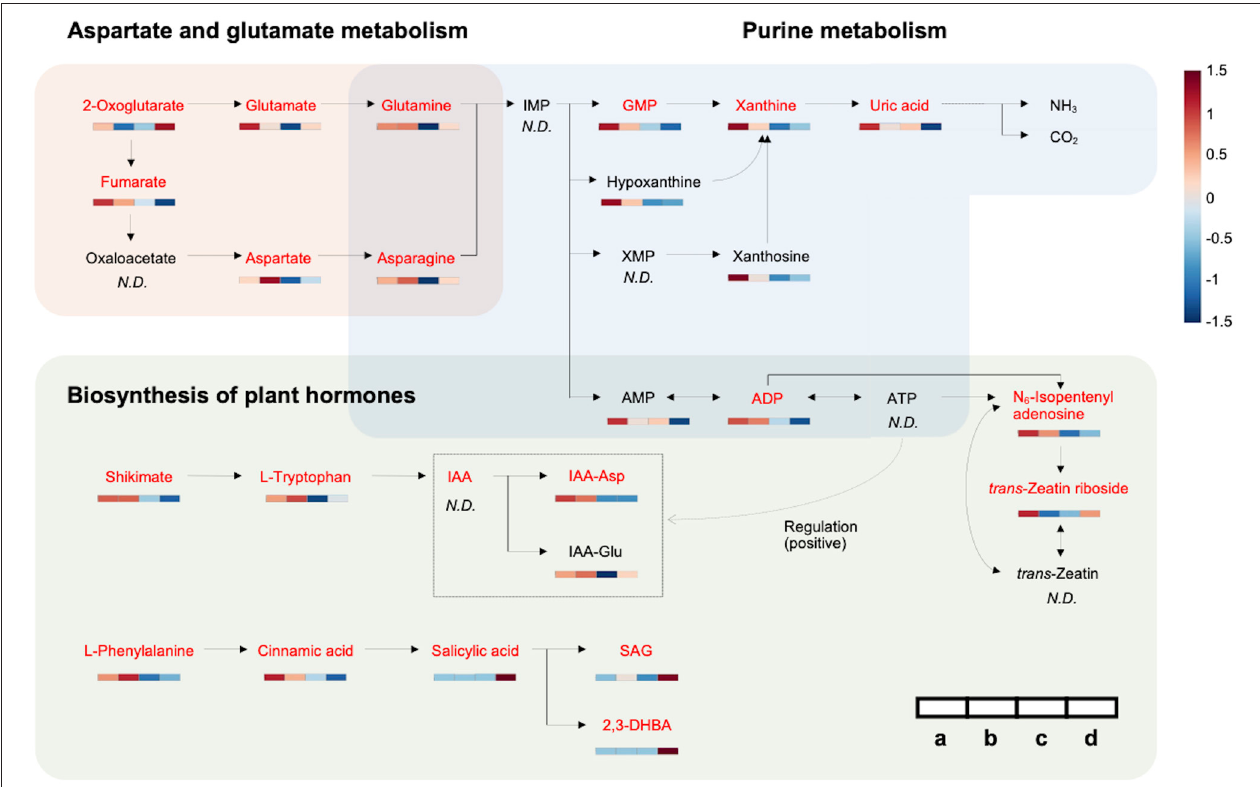
FIGURE 3 | Metabolic network associated with HLB tolerance based on an integrated pathway. Heat maps show metabolic variations in healthy and infected HLB-tolerant and HLB-sensitive groups [(a) healthy HLB-tolerant group, (b) infected HLB-tolerant group, (c) healthy HLB-sensitive group, and (d) infected HLB-sensitive group]. Metabolites with red color indicate marker compounds (VIP score > 1.0, p -value < 0.05, and |fold change| > 1.5) in the network. The color depth of the heat map represents the degree of metabolic responses as follows: red color denotes increased responses and blue color denotes decreased